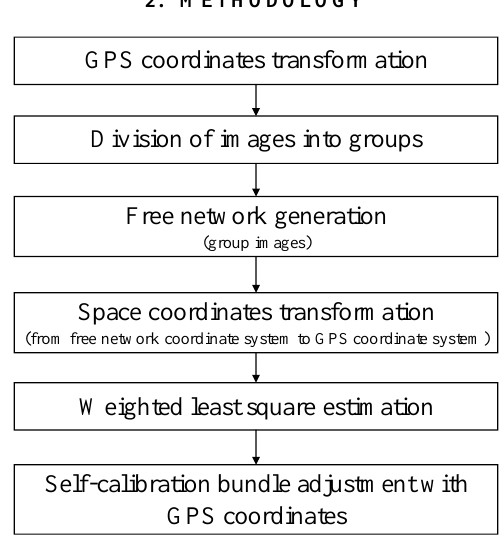
Figure 1. Flow chart of image network